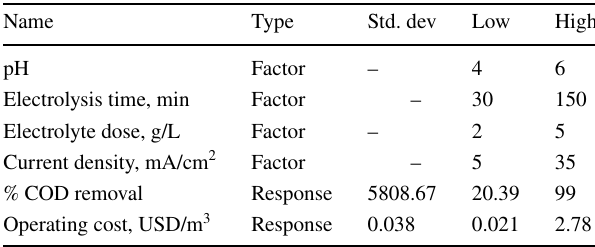
Table 2 Process variables and range of response